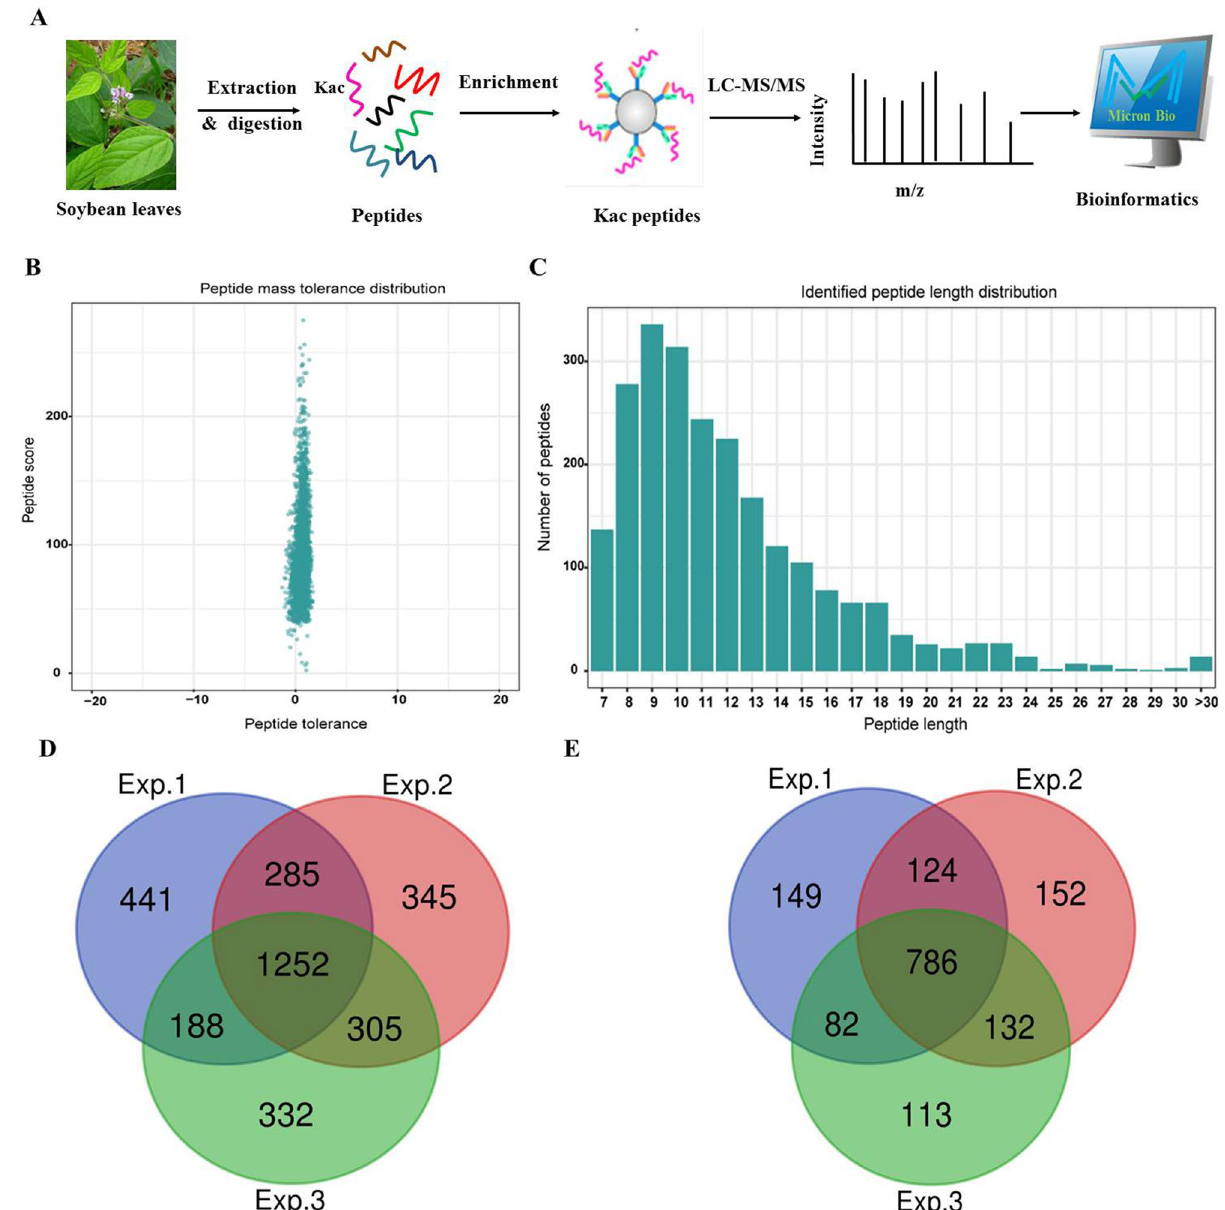
Figure 1. Global analysis of Kac in soybean leaves. ( A ) Experimental procedure for global Kac detection in soybean roots. ( B ) Mass error distribution of all the Kac peptides. ( C ) Peptide length distribution of all the Kac peptides. ( D ) Venn diagram of the identified Kac sites. ( E ) Venn diagram of the identified Kac